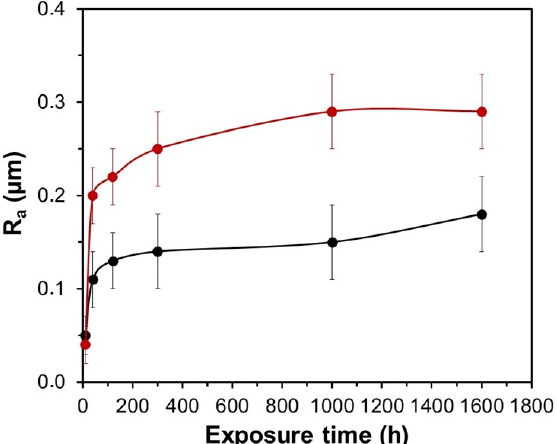
Figure 11. Surface roughness parameter ( R a ) of the oxide scales, determined from contact profilometer, formed on the: ( a ) DS2205 and ( b ) DS2507, after exposing to molten salts for different times.